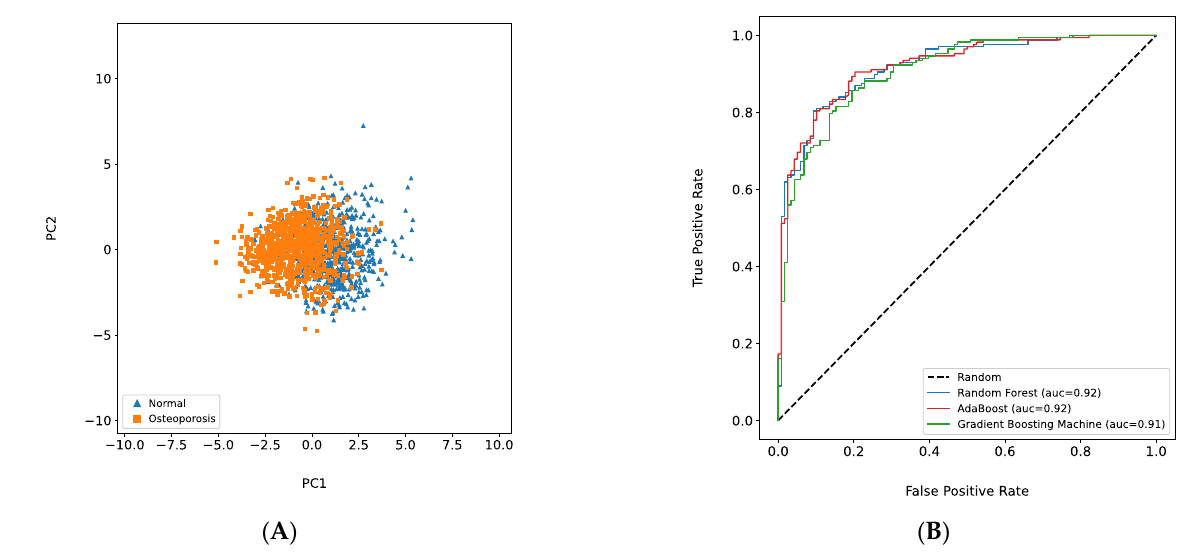
Figure 4. Best Model (Model C) Performance. ( A ): The result of 2D principal component analysis plot based on selected 20 features. ( B ): Receiver operating characteristic (ROC) curve of three different best models (Random Forest, AdaBoost, and Gradient Boosting Machine) based on 20 selected features (total).